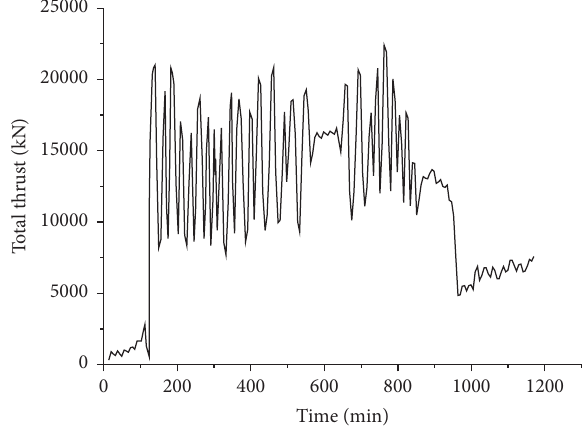
Figure 22: Total thrust variation curve.